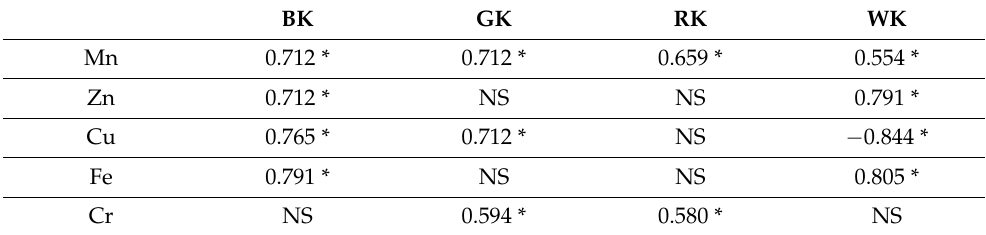
Table 7. Spearman’s rank correlations between fermentation time and microminerals content for different types of